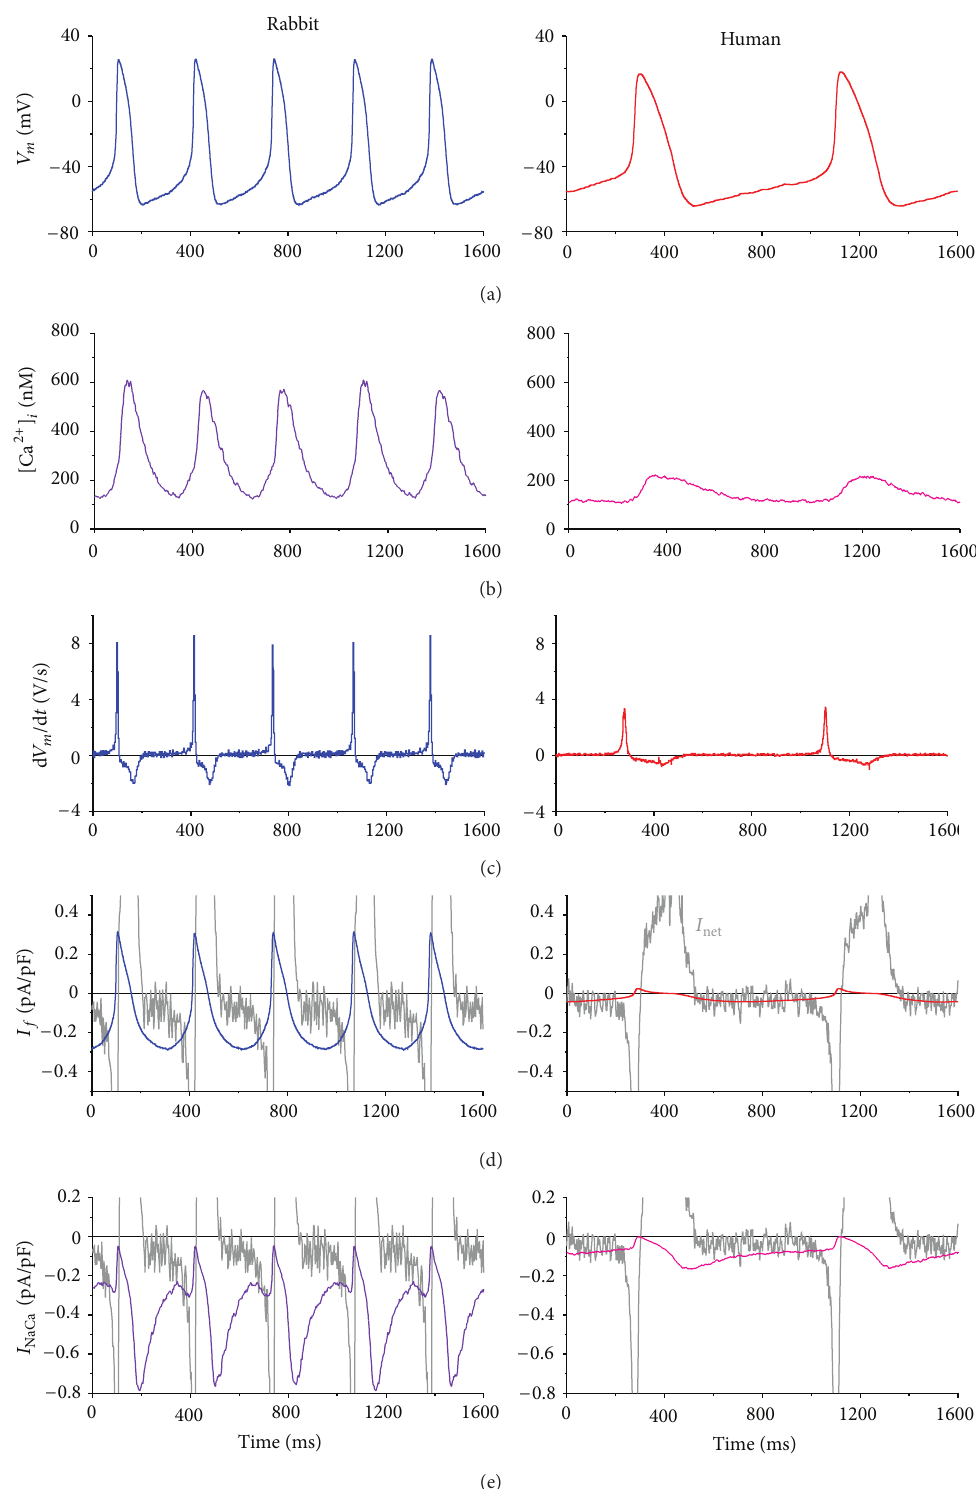
Figure3:Actionpotentialandcalciumtransientrecordingsfromrabbit(left)andhuman(right)SAnodalmyocytesandassociatednumerical reconstructions of membrane currents. (a) Recorded membrane potential 𝑉 𝑚 . (b) Recorded intracellular calcium concentration ( [ Ca 2+ ] 𝑖 ). (c) Time derivative of 𝑉 𝑚 (d 𝑉 𝑚 / d 𝑡 ). (d) Reconstructed hyperpolarization-activated inward current ( 𝐼 𝑓 ). The noisy trace in gray is the net = −𝐶 × d 𝑉 / d 𝑡 , where 𝐶 ) computed from 𝐼 membrane current ( 𝐼 𝑚 𝑚 𝑚 denotes membrane capacitance. (e) Reconstructed sodium-calcium net net ), with the net membrane current in exchange current ( 𝐼 NaCa